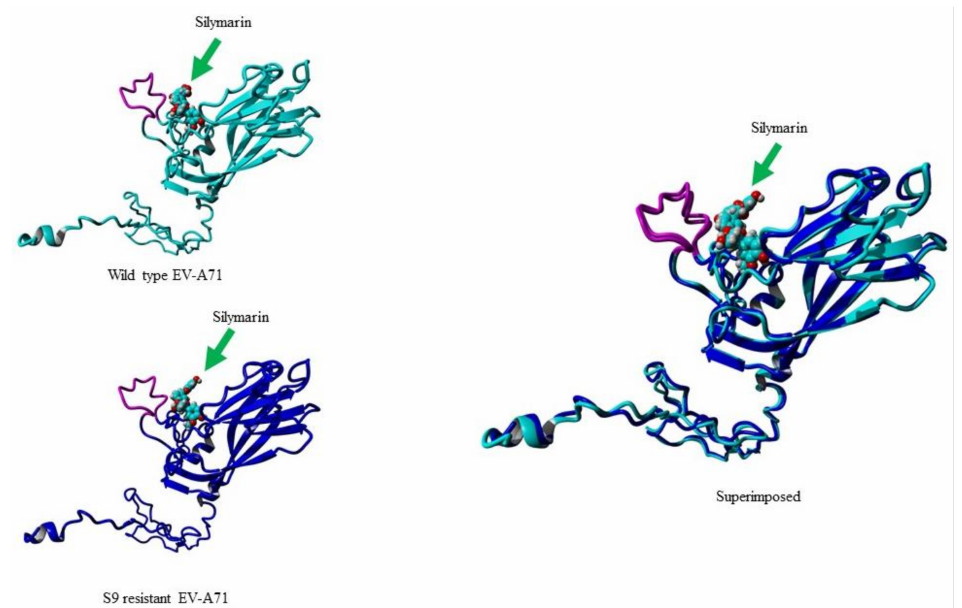
Figure 8. Molecular docking of silymarin with wild type (WT) and silymarin-resistant mutant (S9) of EV-A71 by YASARA v2020. Silymarin in best docking confirmation with homology modeled VP1 of wild type (cyan) and S9 mutant virus (blue). The arrow indicates silymarin interacting with the GH loop (magenta) at the similar position.